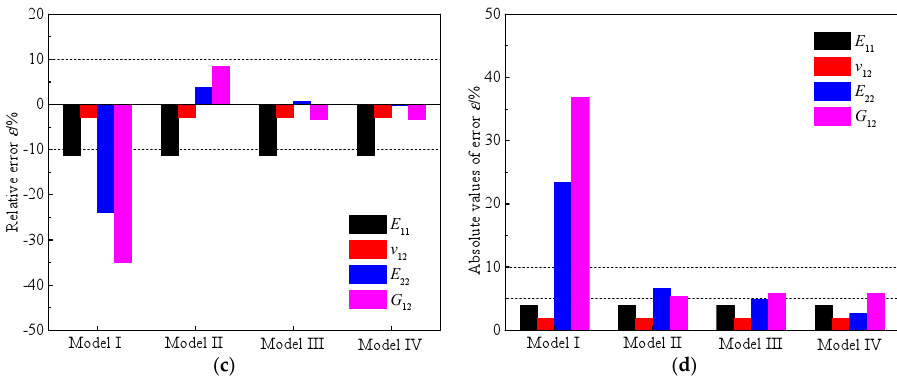
Figure 5. Relative error between the theoretical and experimental elastic parameters of the three composites. ( a ) AS4/3501 − 6; ( b ) T300/BSL914C; ( c ) T800/X850; ( d ) Mean.